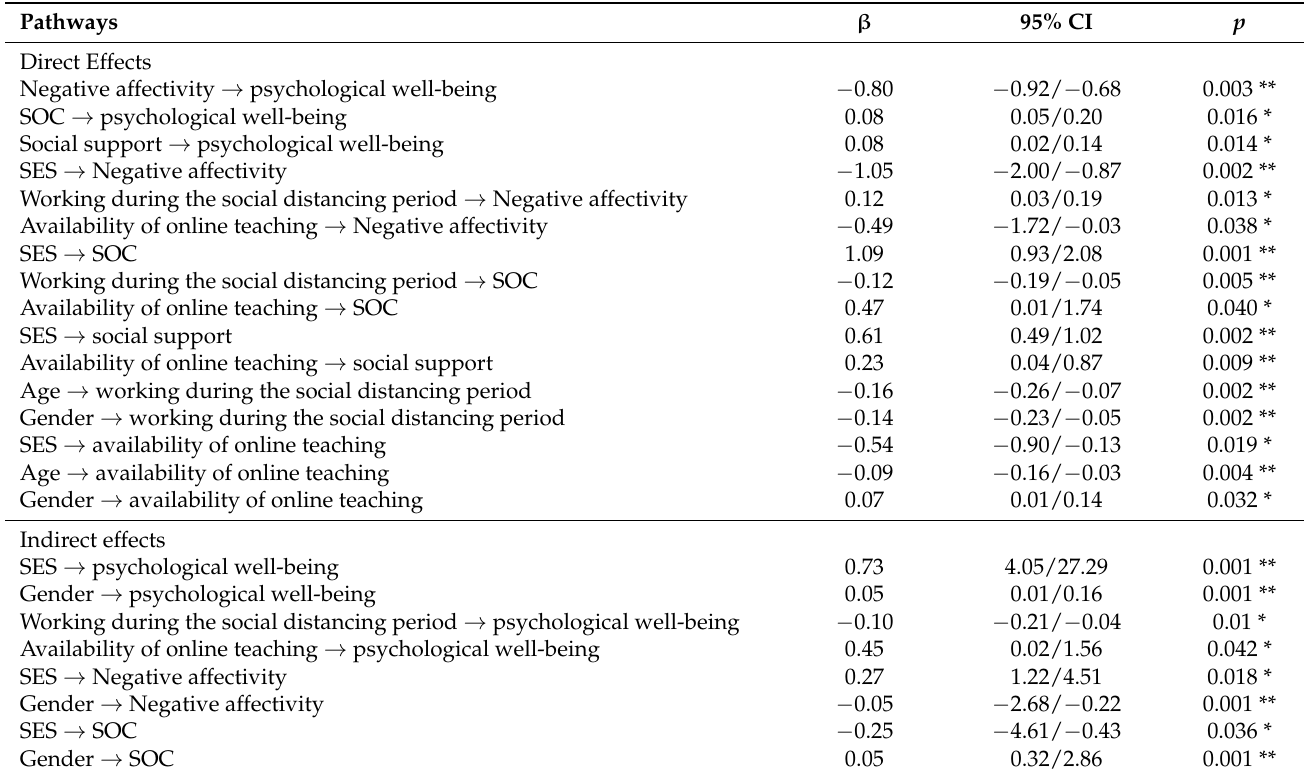
Table 2. Direct and indirect effects of the parsimonious structural equation